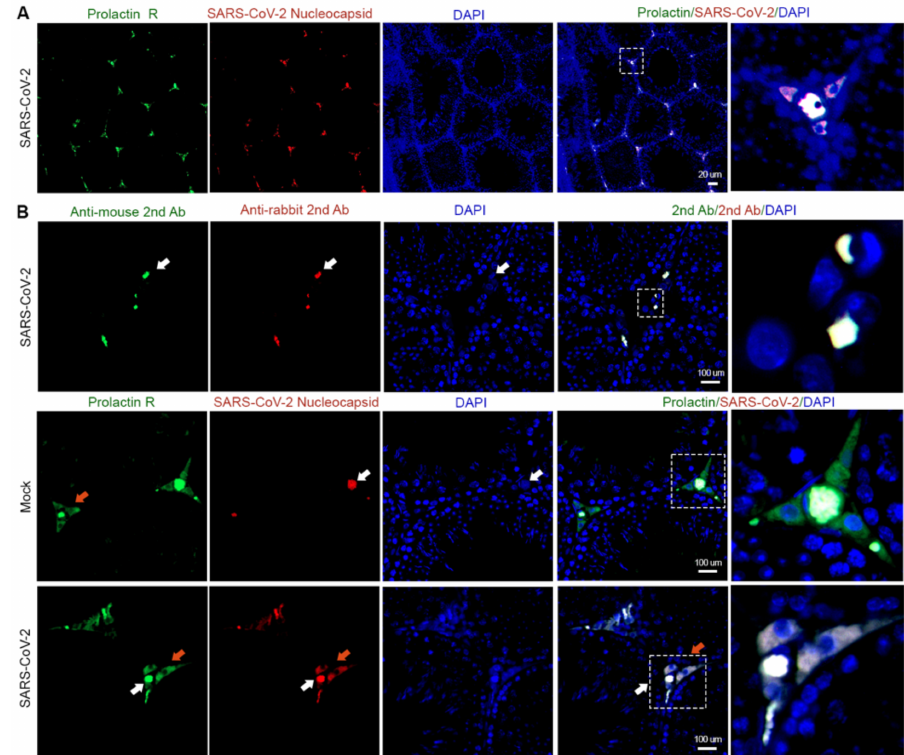
Figure 1. SARS-CoV-2 can infect the Leydig cells from hamster testes. ( A ) At postinfection day (PID) 4, SARS-CoV-2 could be detected by anti-SARS-CoV-2 nucleocapsid antibodies (red signals) in the interstitium. SARS-CoV-2 signals overlap with hamster Leydig cell marker prolactin receptor (Prolactin R, green signals), suggesting that SARS-CoV-2 infected Leydig cells. The area denoted by a white square is enlarged and visualized in the final column of images. (Scale bars: 20 µ m) ( B ) Under high magnification, non-specific signals (white arrows) and specific signals from Prolactin R or SARS-CoV-2 nucleocapsid antibodies (orange arrows) can be distinguished. Non-specific signals were caused by second antibodies, or in the mock group overlap with nuclear signals, indicated by DAPI as extremely shining spots. The area denoted by a white square is enlarged and visualized in the final column of images. Non-specific signals in second antibody-stained cells did not completely overlap with cells. In contrast, prolactin receptor and SARS-CoV-2 nucleocapsid antibody signals did overlap with both the Leydig cell cytoplasm and nucleus. Specific signals overlap with the cytoplasm surrounding the nucleus. (Scale bars: 100 µ